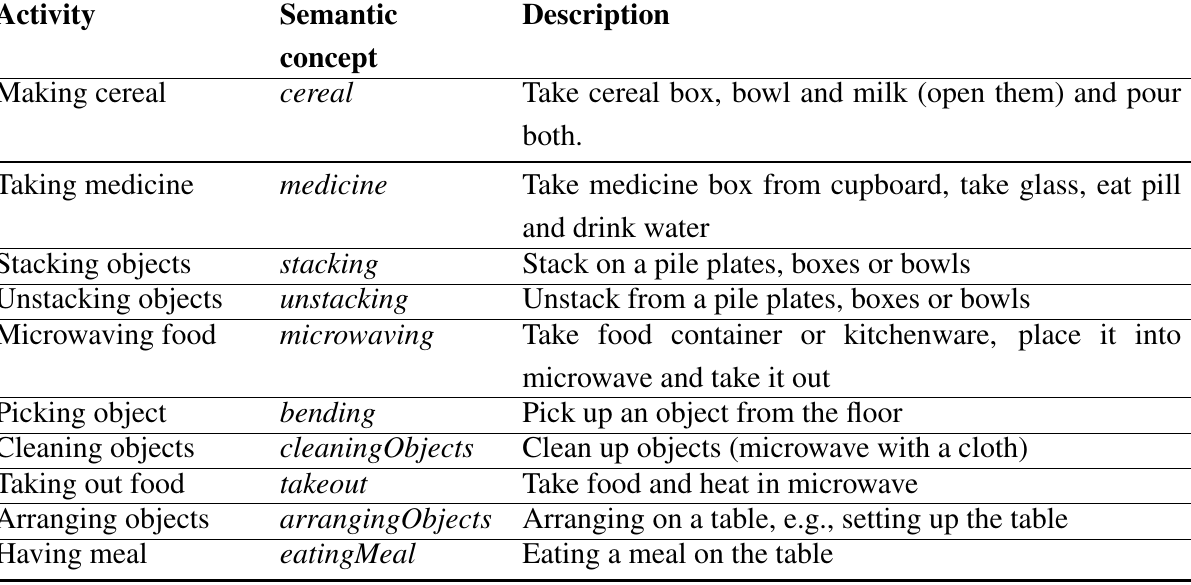
Table 9. Semantic description of each high-level